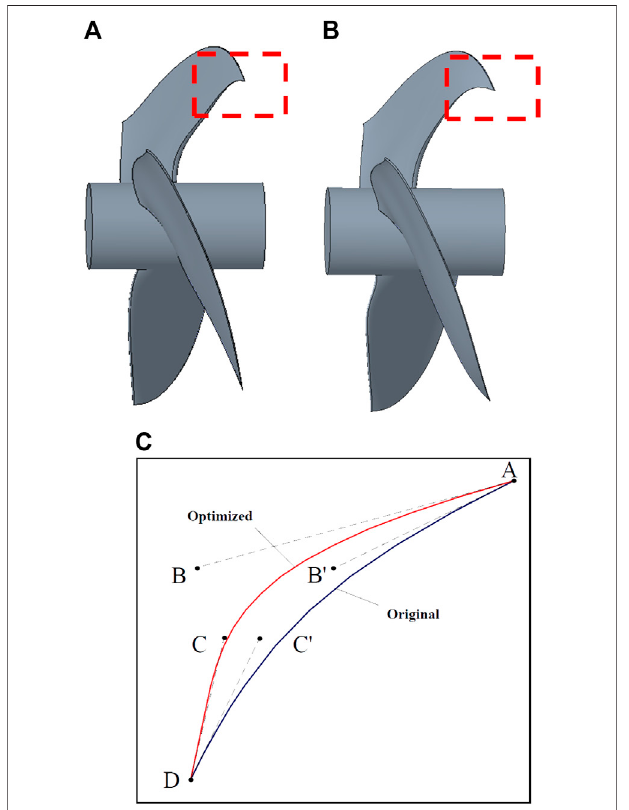
FIGURE15| Comparisonofbladepro fi lesbeforeandafteroptimization. (A) Original. (B) Optimized. (C) Comparison of two blade pro fi les.